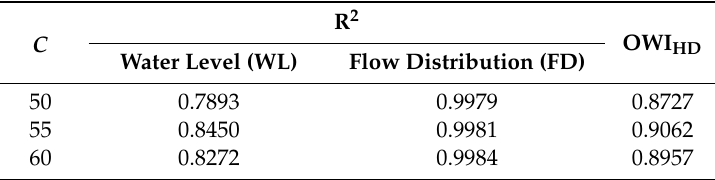
Table 3. Hydrodynamic calibration